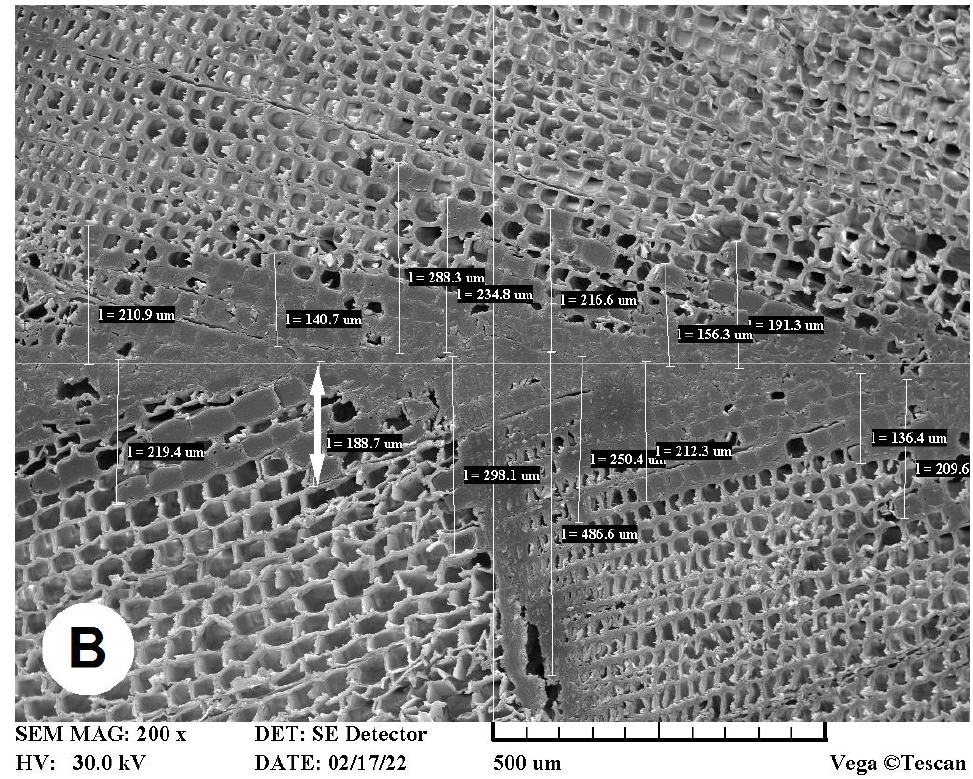
Figure 2. The methodology of recording ( A ) the thickness of the glue line of PVAc glue for testing set IV = 200 ◦ C/200 ◦ C, and ( B ) the penetration depth of PUR glue into the structure of TM spruce wood (highlighted with white arrow) for testing set V = 220 ◦ C/220 ◦